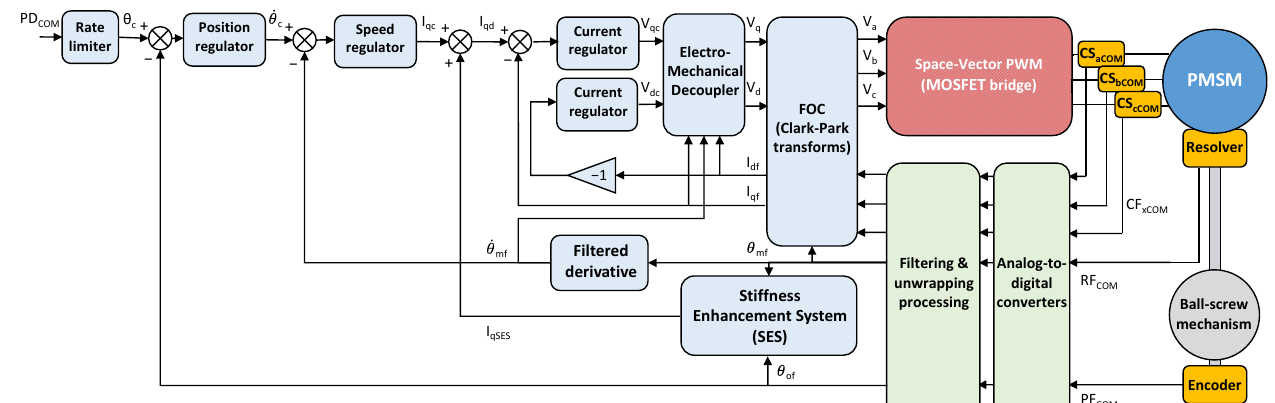
Figure 7. Closed-loop control scheme of the actuator.